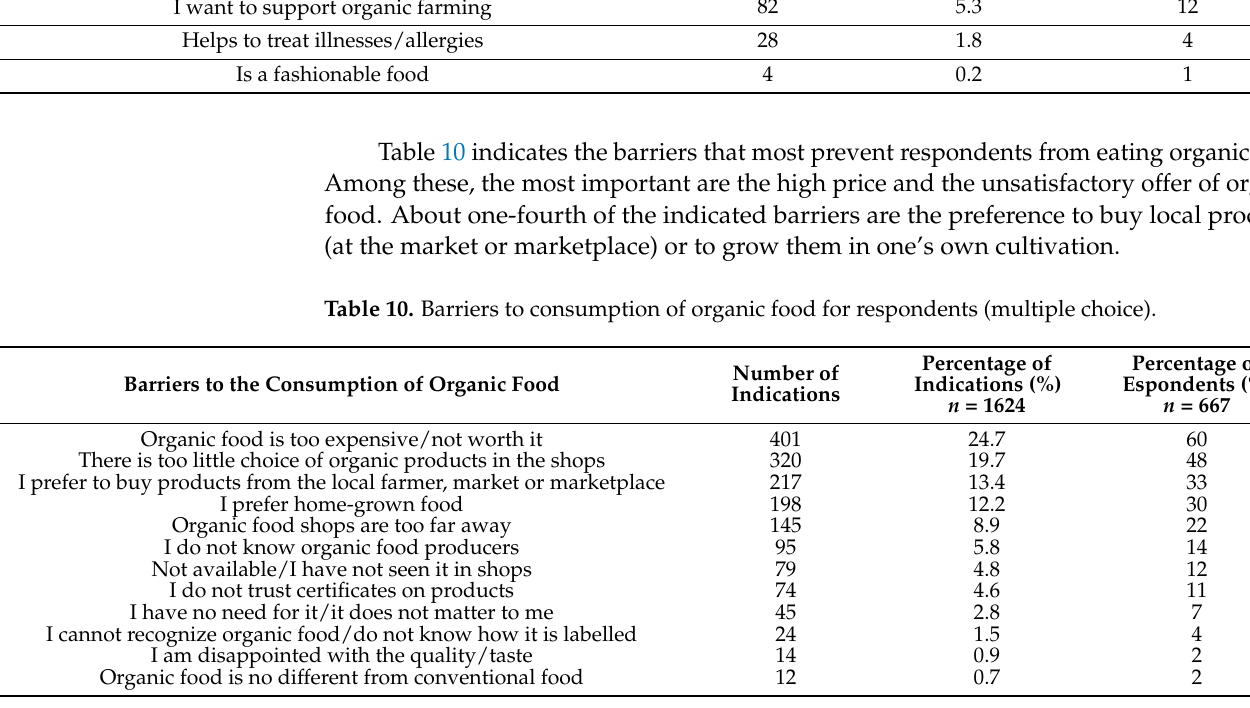
Table 10 indicates the barriers that most prevent respondents from eating organic food.